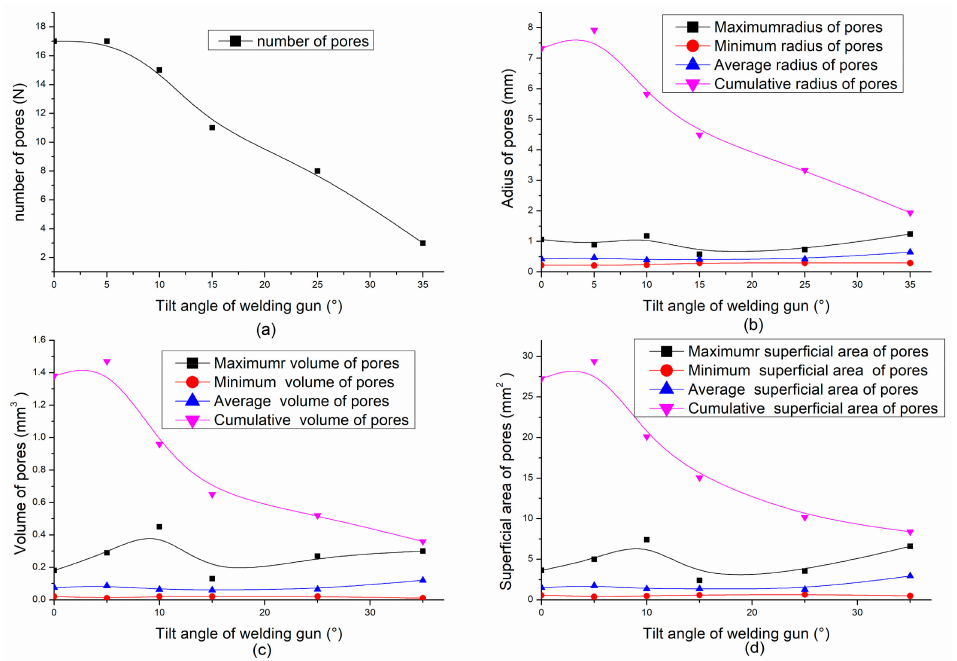
Figure 3. Influence of arc tilt on welding pores for ( a ) number of pores and ( b ) radius of pores and ( c ) volume of pores and ( d ) superficial area of